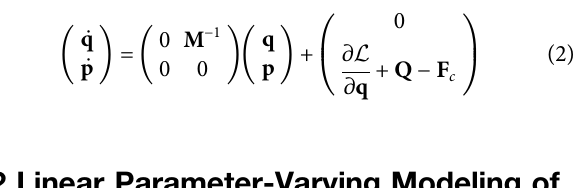
Frontiers in Robotics and AI |